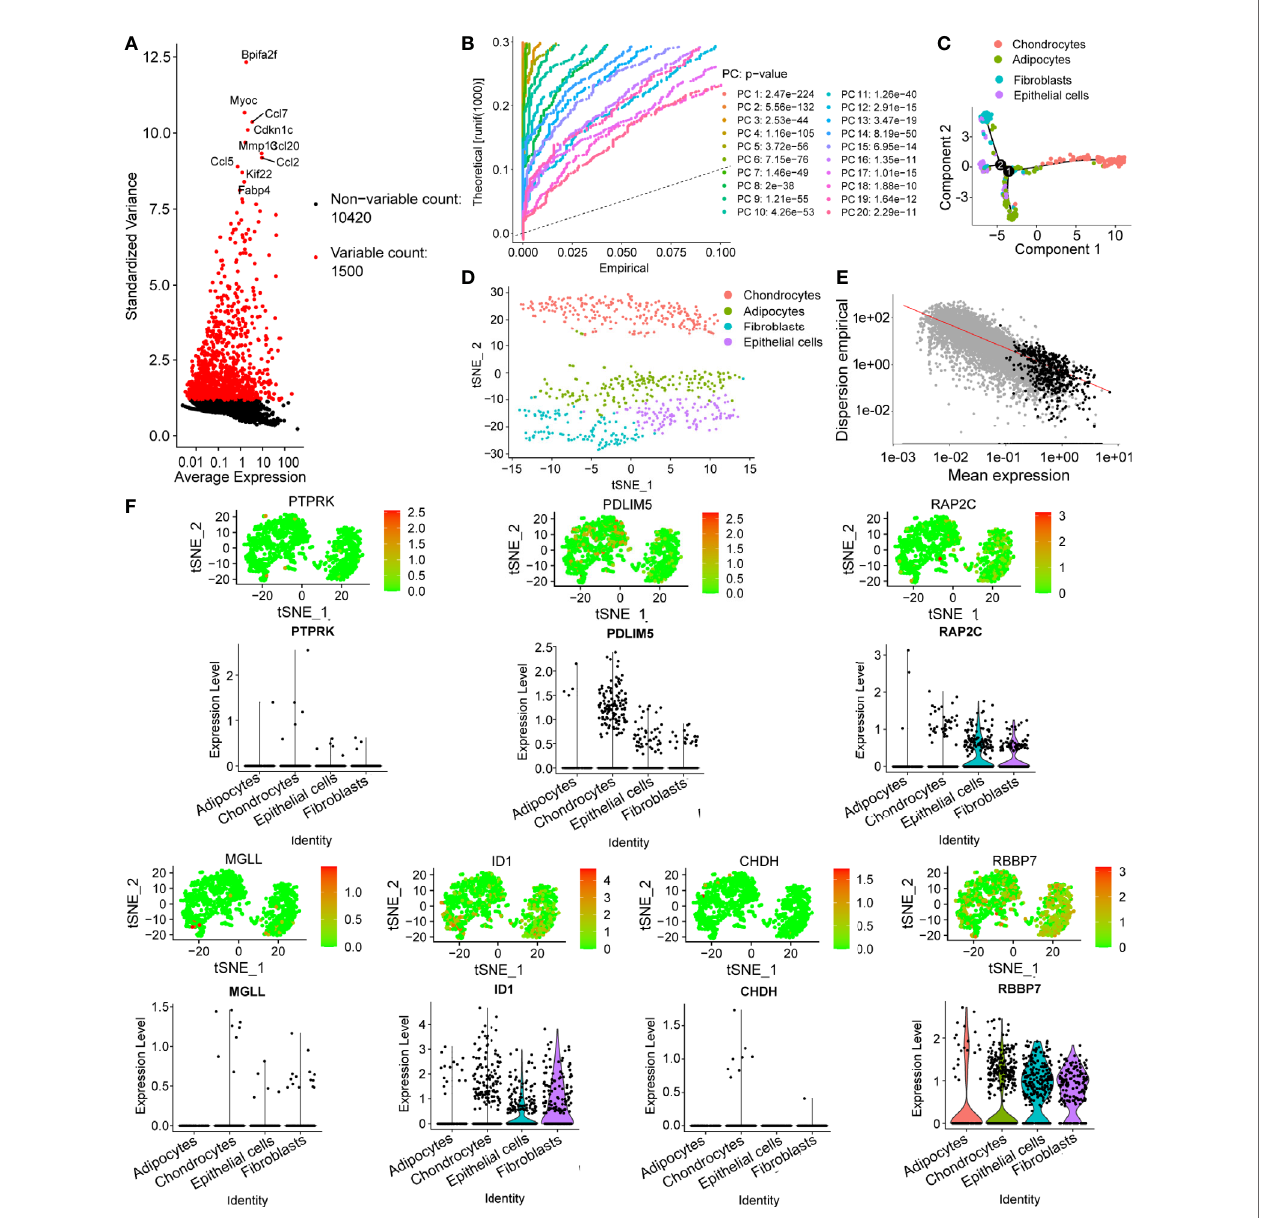
FIGURE 4 | Preprocessing of the single-cell sequencing data and cell cluster identi fi cation. (A, B) Gene fi ltering and PCA clustering of the gene expression matrix. (C) t-SNE projections and cell subset annotation of intervertebral disc (IVD) tissue. (D) Quality control process for the trajectory analysis using the DDRTree method. (E) Cell trajectory analysis of single cells in IVDs shows distinct lineage cells in different clusters. (F) Expression pattern of key genes at the single-cell level, shown in t-SNE fi gures and violin